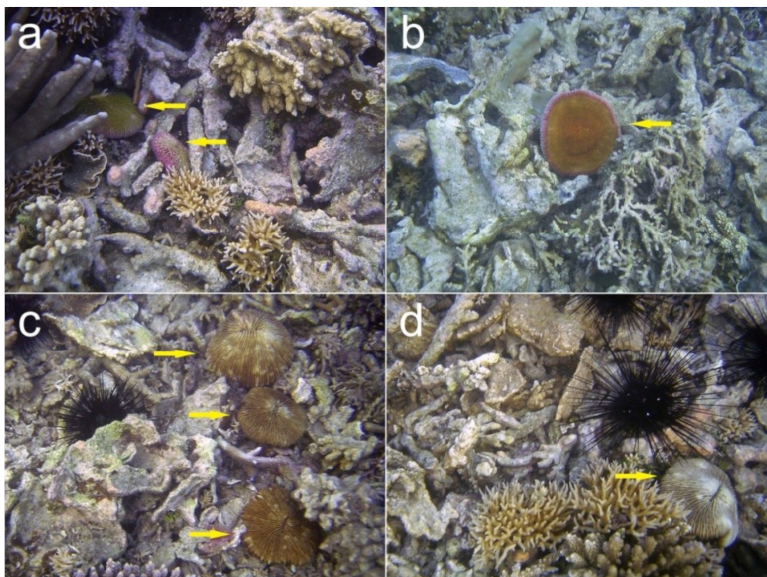
Figure 8. Reef flat of Pulau Putri at ca. 5 m depth (Zone 3), damaged by blast fishing. Free-living mushroom corals (arrows) are scattered among dead and live fragments of other corals: ( a,b ) Fungia fungites ; ( c,d ) Lithophyllon repanda . Date: